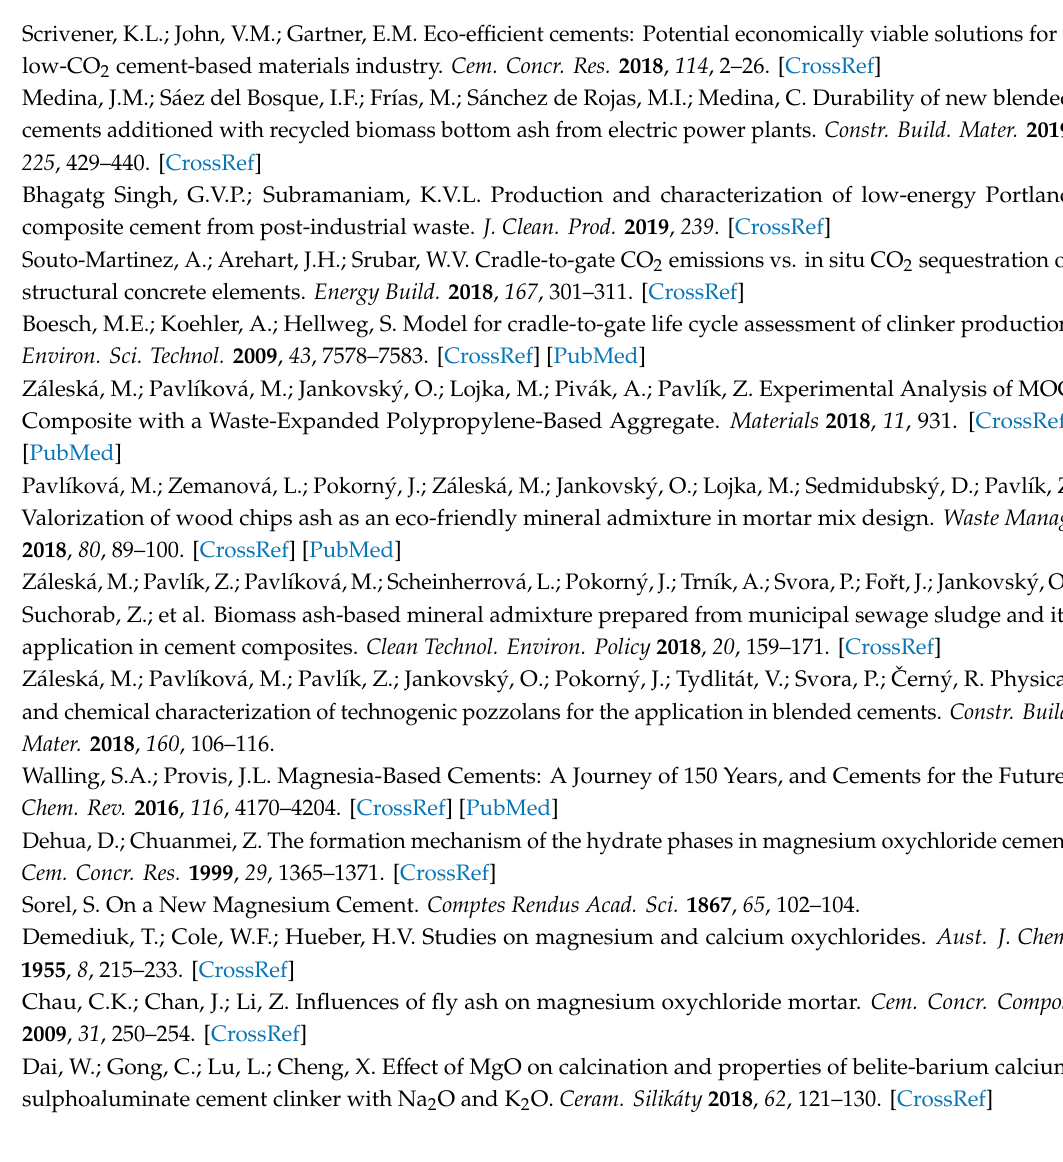
Figure S1: Di ff ractograms of raw materials MgO and MgCl 2 · 6H 2